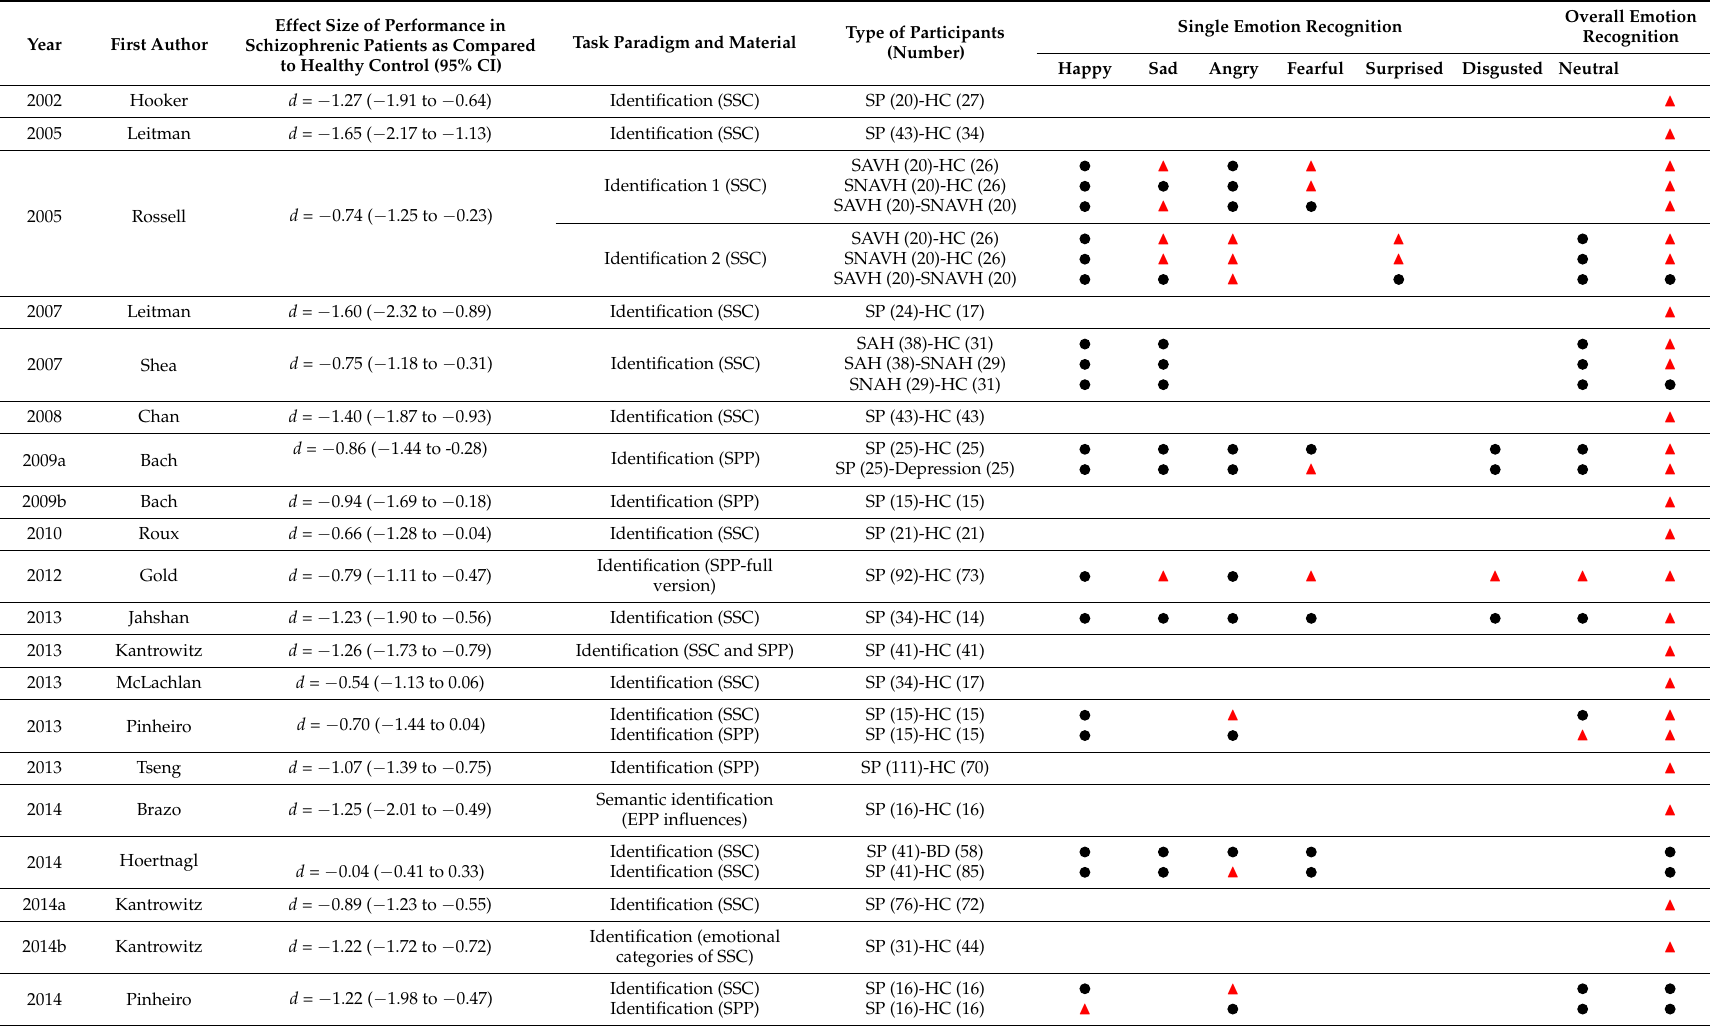
Table 2. EPP performance of participant groups (Identification